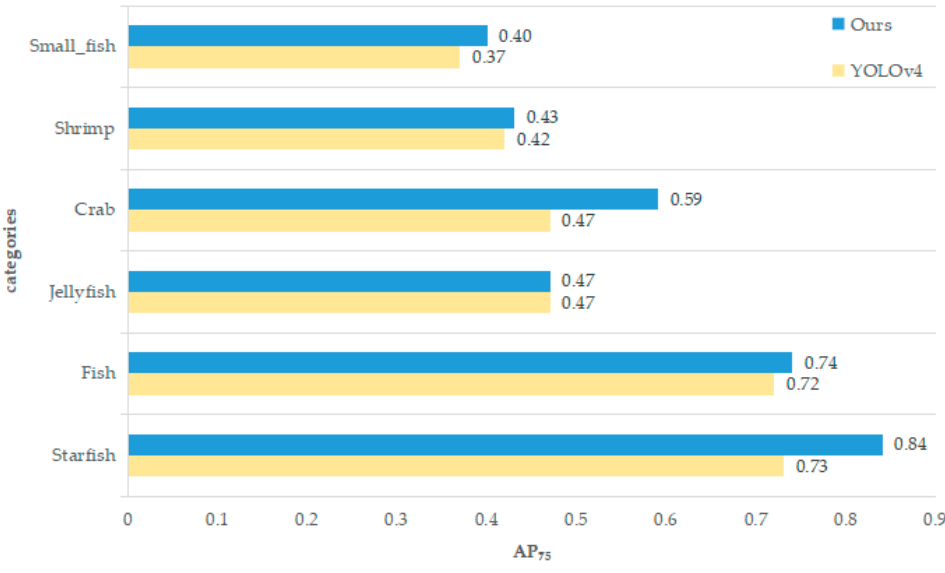
Figure 4. Comparison of detection accuracy AP 75 results for each category.